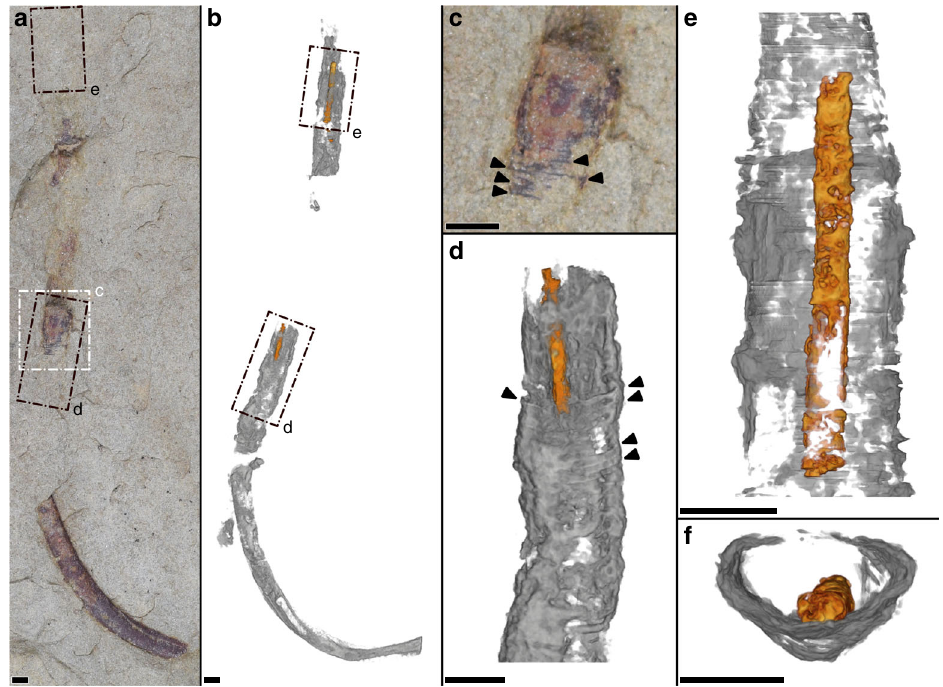
Fig. 4 Optical imaging and µ CT of cloudinomorph pyritized tube and soft tissue. a Light image of entire specimen (sample USNM-WCF_001) in plan- view, specimen partially obscured at rock surface. b Corresponding 3D volume render, showing soft tissue (orange) and tube wall (gray); boxes d , e are marked in both a , b to help guide slight differences in orientation. c Close-up view of labeled box in a , highlighting funnel rims (arrows) on external tube. d Close-up view of labeled boxes in a , b , 3D volume render showing partial soft tissue and funnel rims (arrows); d largely overlaps with c , but includes also host rock encased portion of the fossil. e Partial soft tissue from labeled boxes in a , b . f Cross-sectional view of e showing relative position of soft tissue that has settled to the bottom of the external tube wall. Sample reposited at the Smithsonian Institution. All scales = 2 mm.